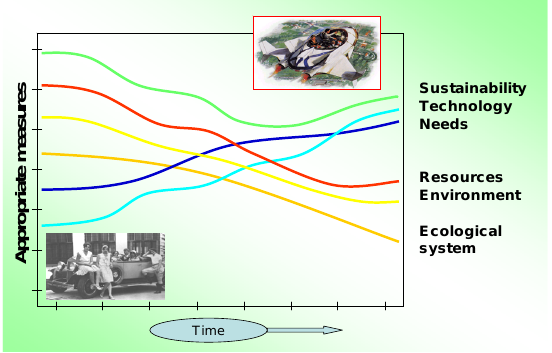
Fig 3. Effect of technology on the sustainable development